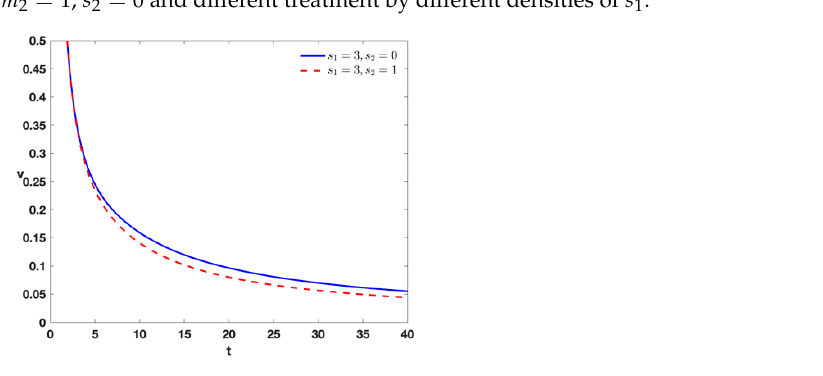
Figure 5. Time series of tumor cells with a = 0.9, m 1 = 1, k 1 = 0.5, b = 1, c = 3, d = 2.5, k 2 = 1,